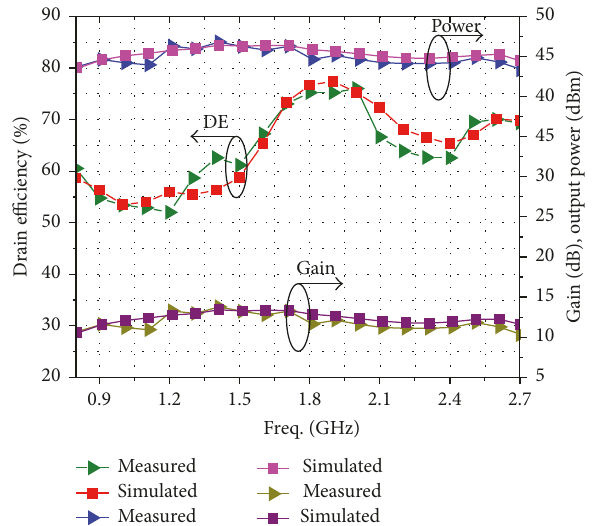
Figure 11: Measured drain efficiency versus output power at 0.8, 1.7, 2.0, and 2.6 GHz.